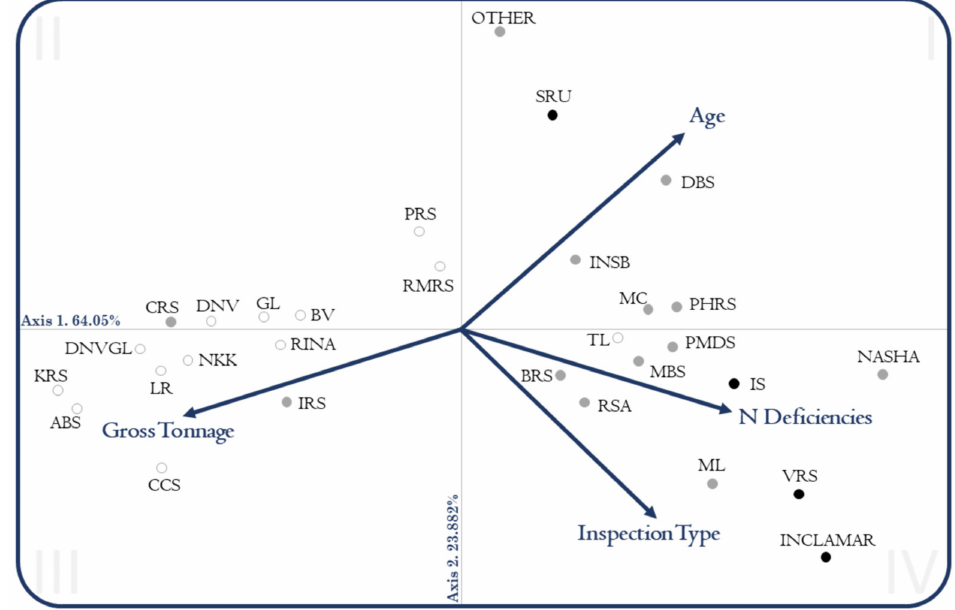
Figure 6. Representation of the compromise matrix subspace, 30 classification certificates and four